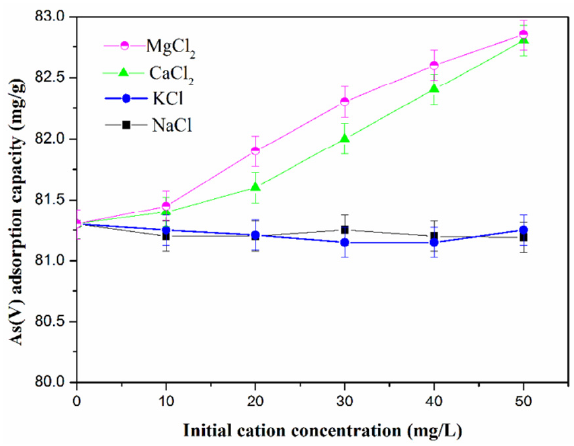
Figure 23. Effects of different cations on the adsorption of 25 mg/L As(V) at 298 K [96]. Reprinted with permission from Fanqing Meng et al. (2017). Copyright 2017 American Chemical Society.